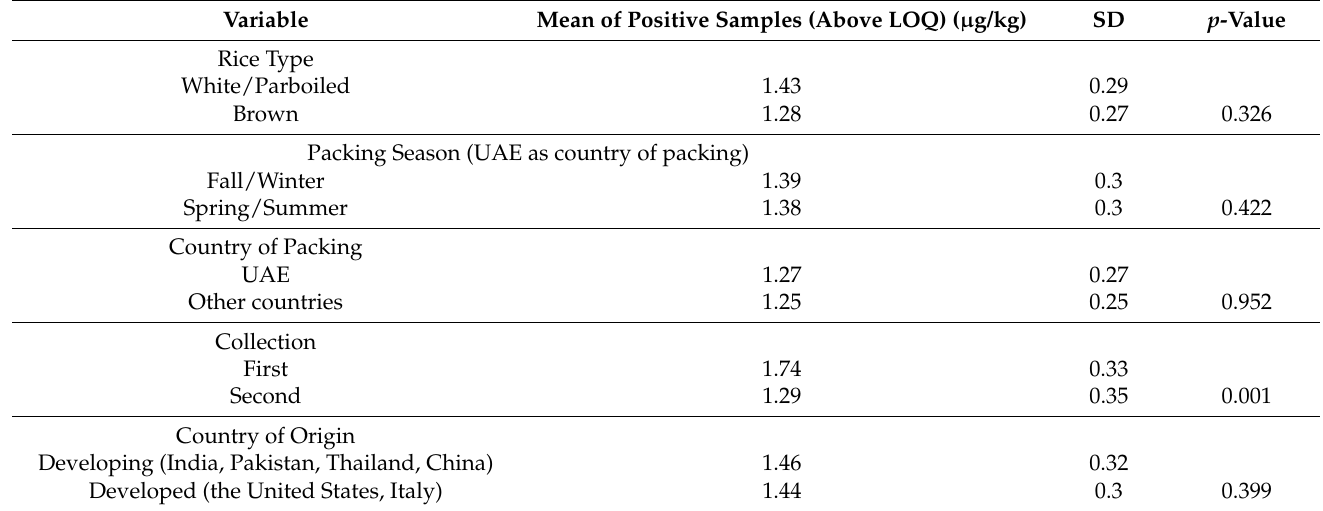
Table 2. Effects of different parameters on OTA in rice collected in